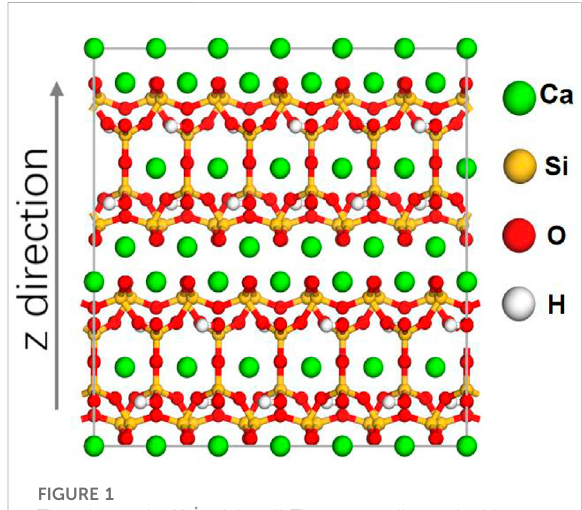
FIGURE 1 The tobermorite 11 Å origin cell. The green, yellow red, white spheres represent the calcium, silicon and hydrogen, respectively.